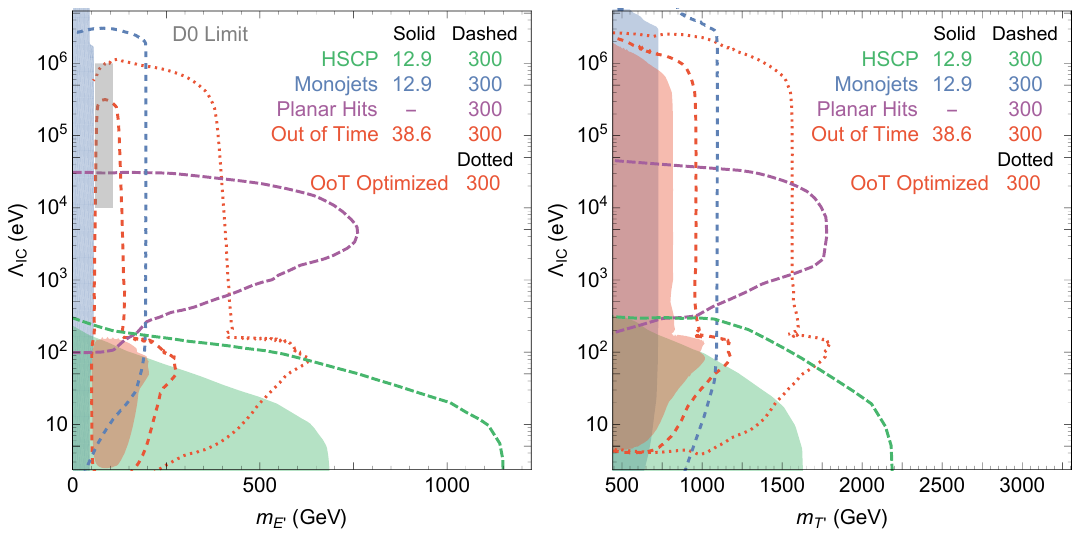
Figure 5 . Left: Current and projected constraints on E 0 -like quirks (standard model quantum numbers of the right-handed electron (1 ; 1) 1 ) with a con(cid:12)ning SU(2) IC force. Right: Current and projected constraints on T 0 -like quirks (standard model quantum numbers of the right-handed top quark ((cid:22)3 ; 1) ) with a con(cid:12)ning SU(2) IC force. The limits from the existing CMS out-of-time (cid:0) 2 3 search [34] are shown in solid red. Projected limits at 300 fb (cid:0) 1 using a na(cid:127)(cid:16)ve extrapolation where an identical search strategy with the same acceptance is shown in dashed red. A hypothetical optimization of the search where the entire calorimeter is included, j (cid:17) j < 3, and backgrounds are reduced to zero, e.g. via higher energy thresholds, to illustrate the possible sensitivity achievable through this method is shown with the dotted red line. Limits from HSCP and monojet searches [29] are shown in green and blue, respectively. The proposed planar hit search [31] is shown in purple for 300 fb (cid:0) 1 . The limit on E 0 -like quirks from D0 [26] is shown in